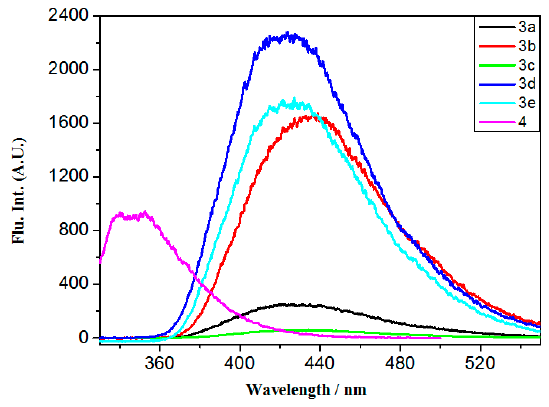
Figure 2. The emission spectra of compounds 3 ( a – e ), 4 .